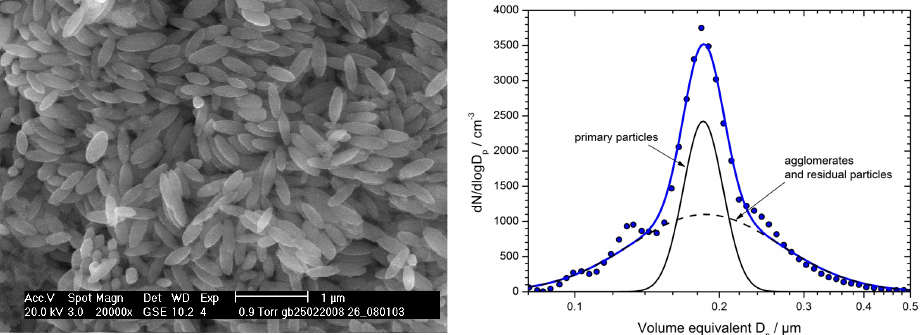
Fig. 7. Left: electron micrograph of the synthetic hematite particle sample used in this study. The aspect ratio of the prolate spheroidal particles was found to be very uniform with a mean value of 0.37. Right: size distribution of the aerosol sample after dispersion into the AIDA chamber. The narrow mode can be attributed to the primary hematite spheroids while the broad mode is likely induced by residual akaganeit particles and particle